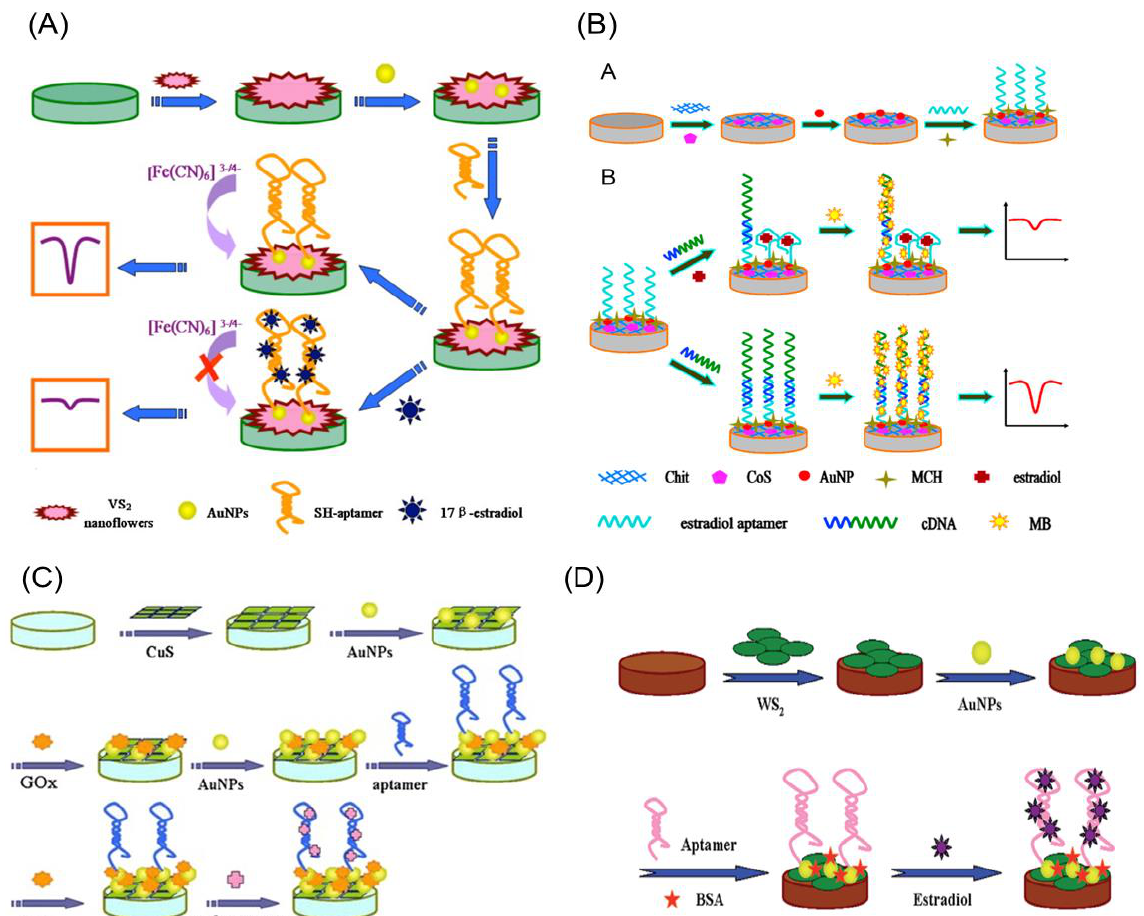
Figure 9. Electrochemical aptasensors based on semiconducting 2D-TMC and 2D-TMD electrode platforms for E2 detection. The semiconducting 2D-TMC and 2D-TMD aptasensor electrode platforms are ( A ) glassy carbon/VS 2 nanoflower/gold–aptamer electrode. Reprinted with permission from Ref. [50]. copyright © 2022, Elsevier, ( B ) glassy carbon/CoS nanosheets/gold–aptamer electrode. Reprinted with permission from Ref. [42]. copyright © 2022, Elsevier, ( C ) glassy carbon/CuS/gold– aptamer electrode. Reprinted with permission from Ref. [52]. copyright © 2022, Springer-Verlag Wien, ( D ) glassy carbon/WS 2 /gold–aptamer electrode. Reprinted with permission from Ref. [51]. copyright © 2022, The Royal Society of Chemistry. The gold–thiol bond aptamer immobilization strategy was implemented for semiconducting 2D-TMC and 2D-TMD